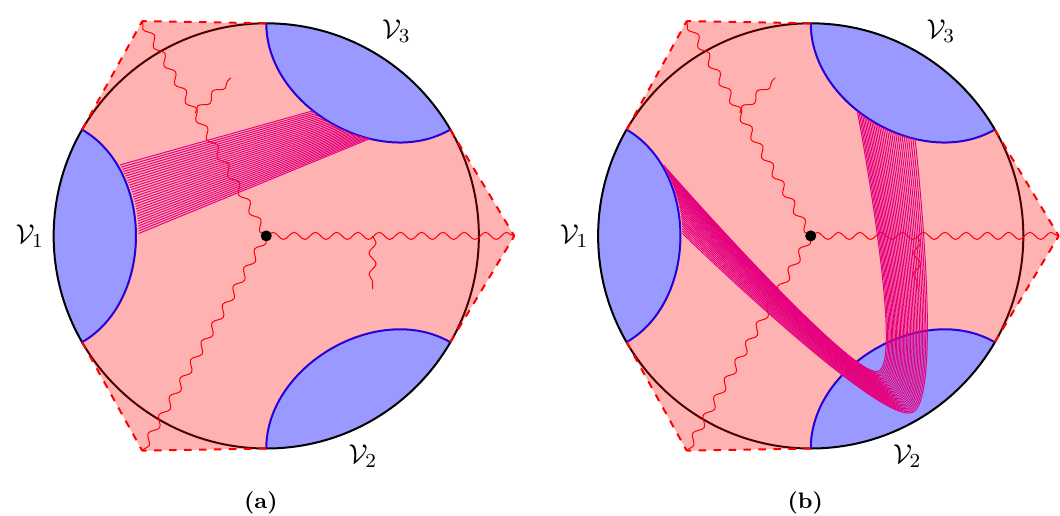
Figure 14. As explained in the text, a nonempty interior for J ( E V implies that there is an open family of curves contained in J − ( E ( E Σ)) that connects E V ∩ may pass through E